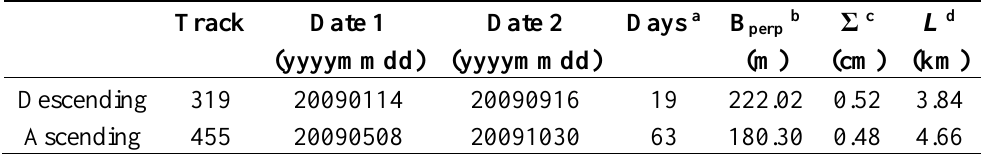
Table 2. SAR satellite data used in this study.